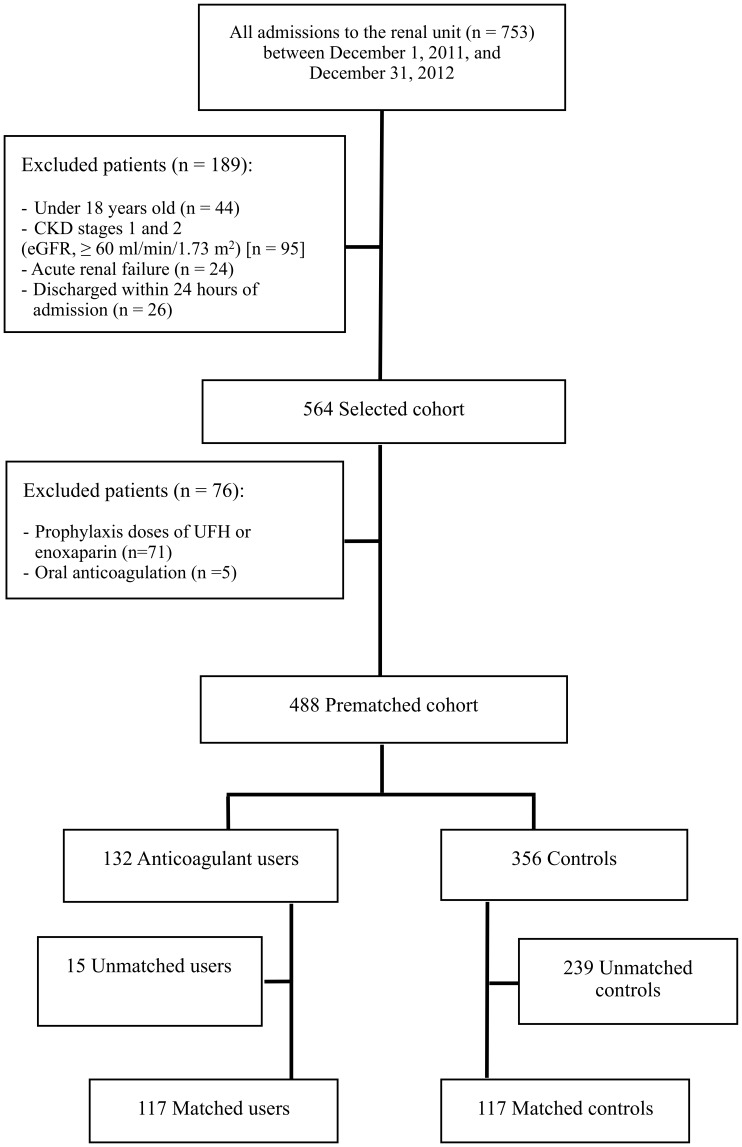
Cohort creation.